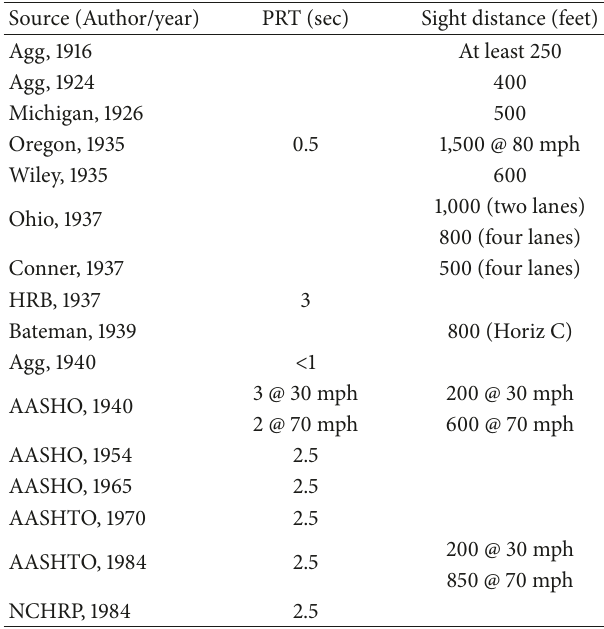
Table 1: Development of SSD model